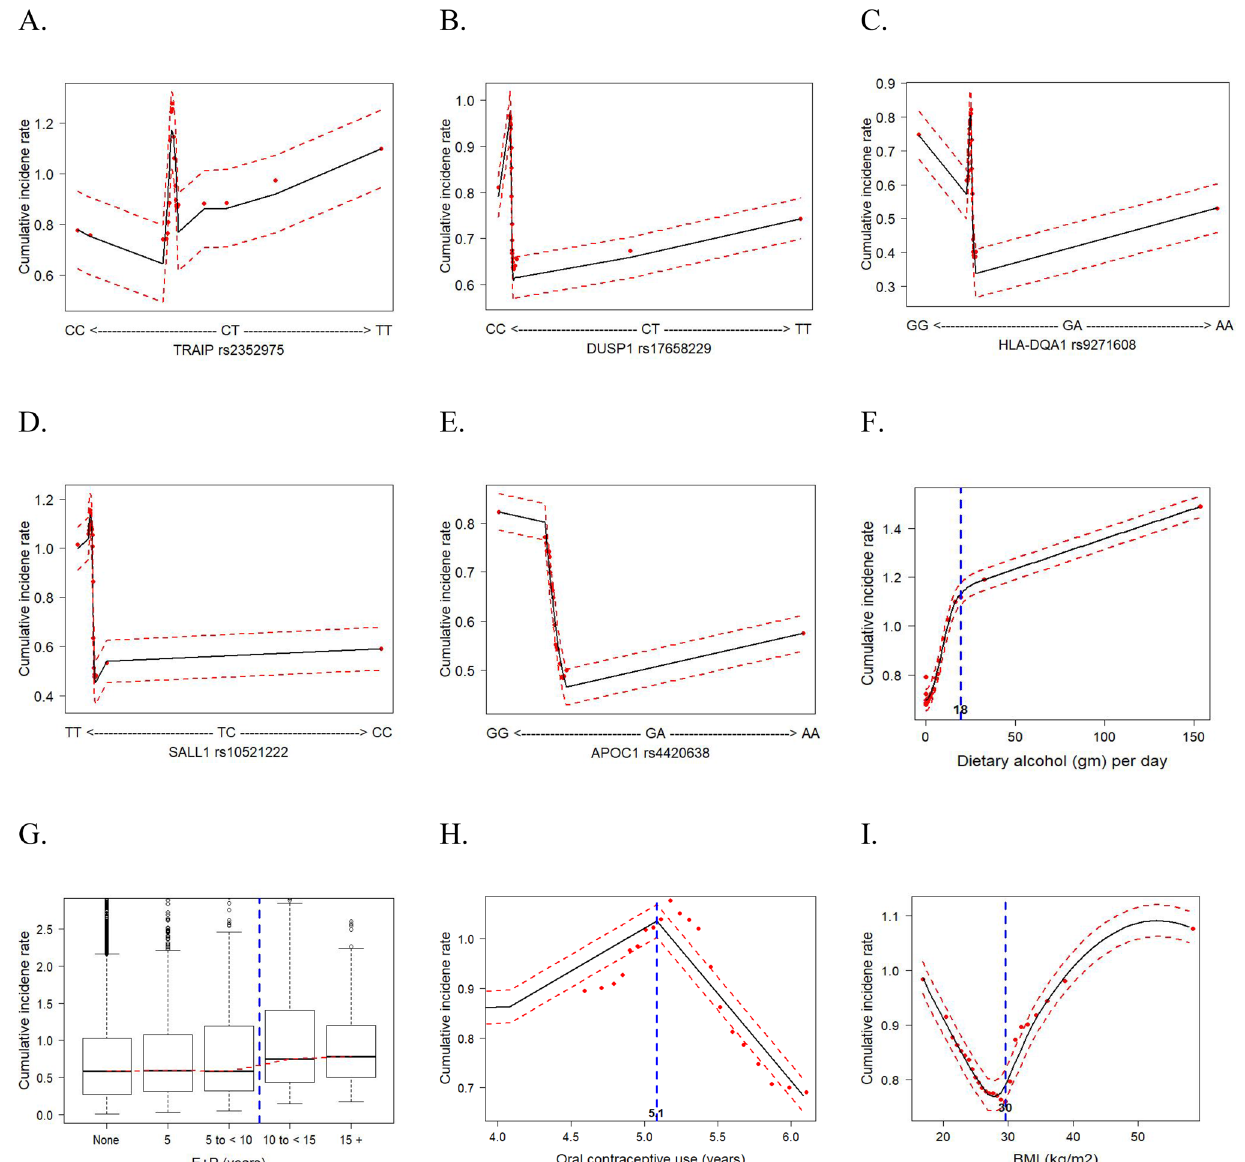
Figure 2. Cumulative breast cancer incidence rate for the 9 most influential variables (5 SNPs and 4 behavioral factors) based on random survival forest analyses. (E + P, exogenous estrogen + progestin; SNPs, single- nucleotide polymorphisms. Dashed red lines indicate 95% confidence